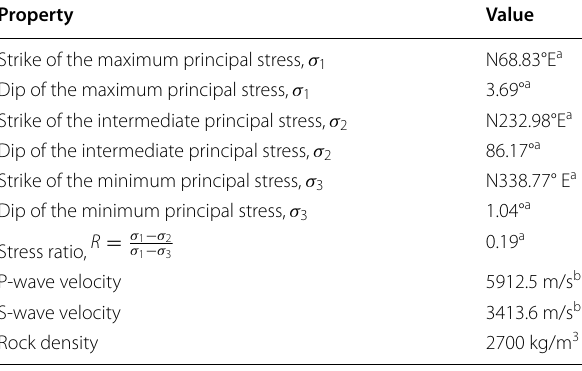
a The regional stress field was estimated by Yoshida et al. (2016) b Averages of the velocities at depths from 0 to 20 km obtained by Saiga et al. (2010)